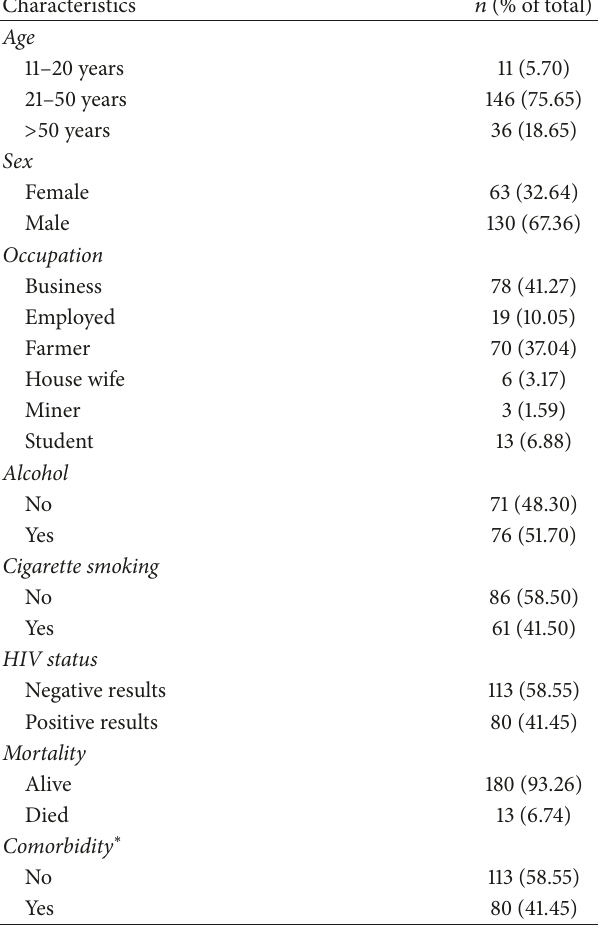
Table 1: Descriptive sociodemographic characteristics of study participants (𝑁 = 193)